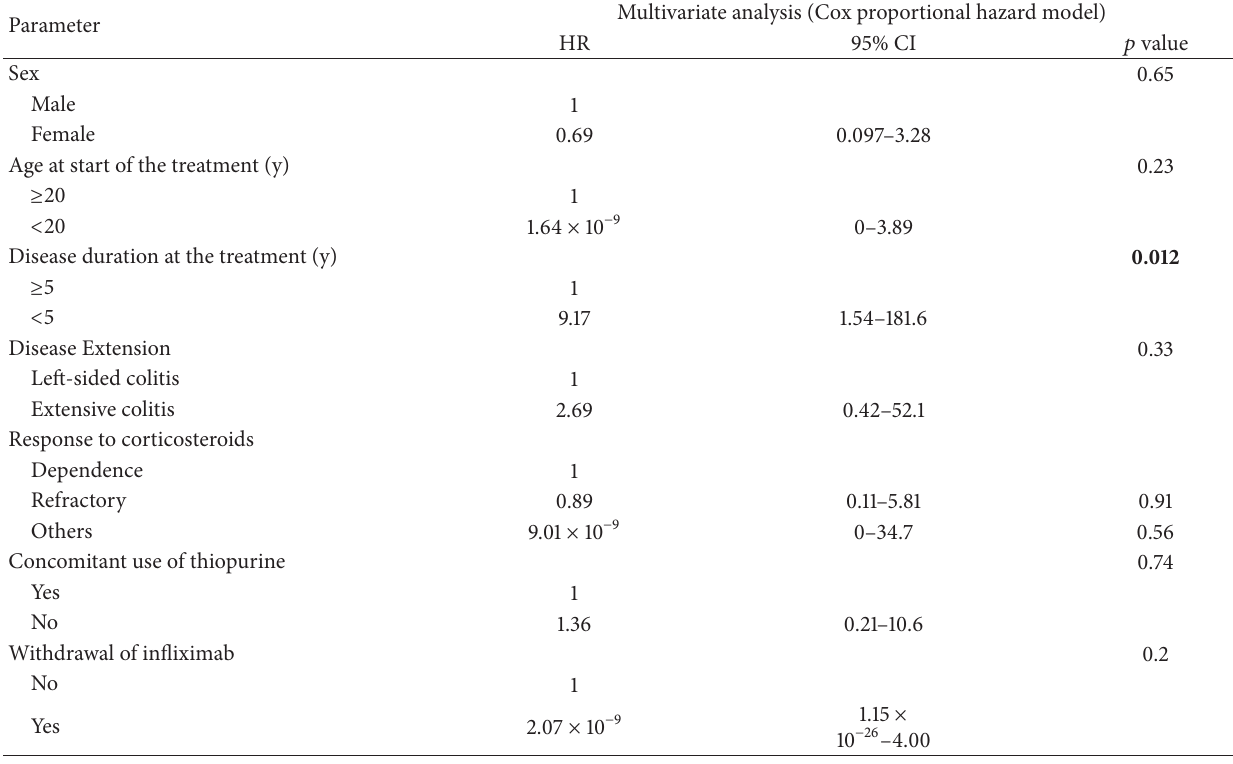
Table 2: Cox proportional hazard model for relapse in IFX group.